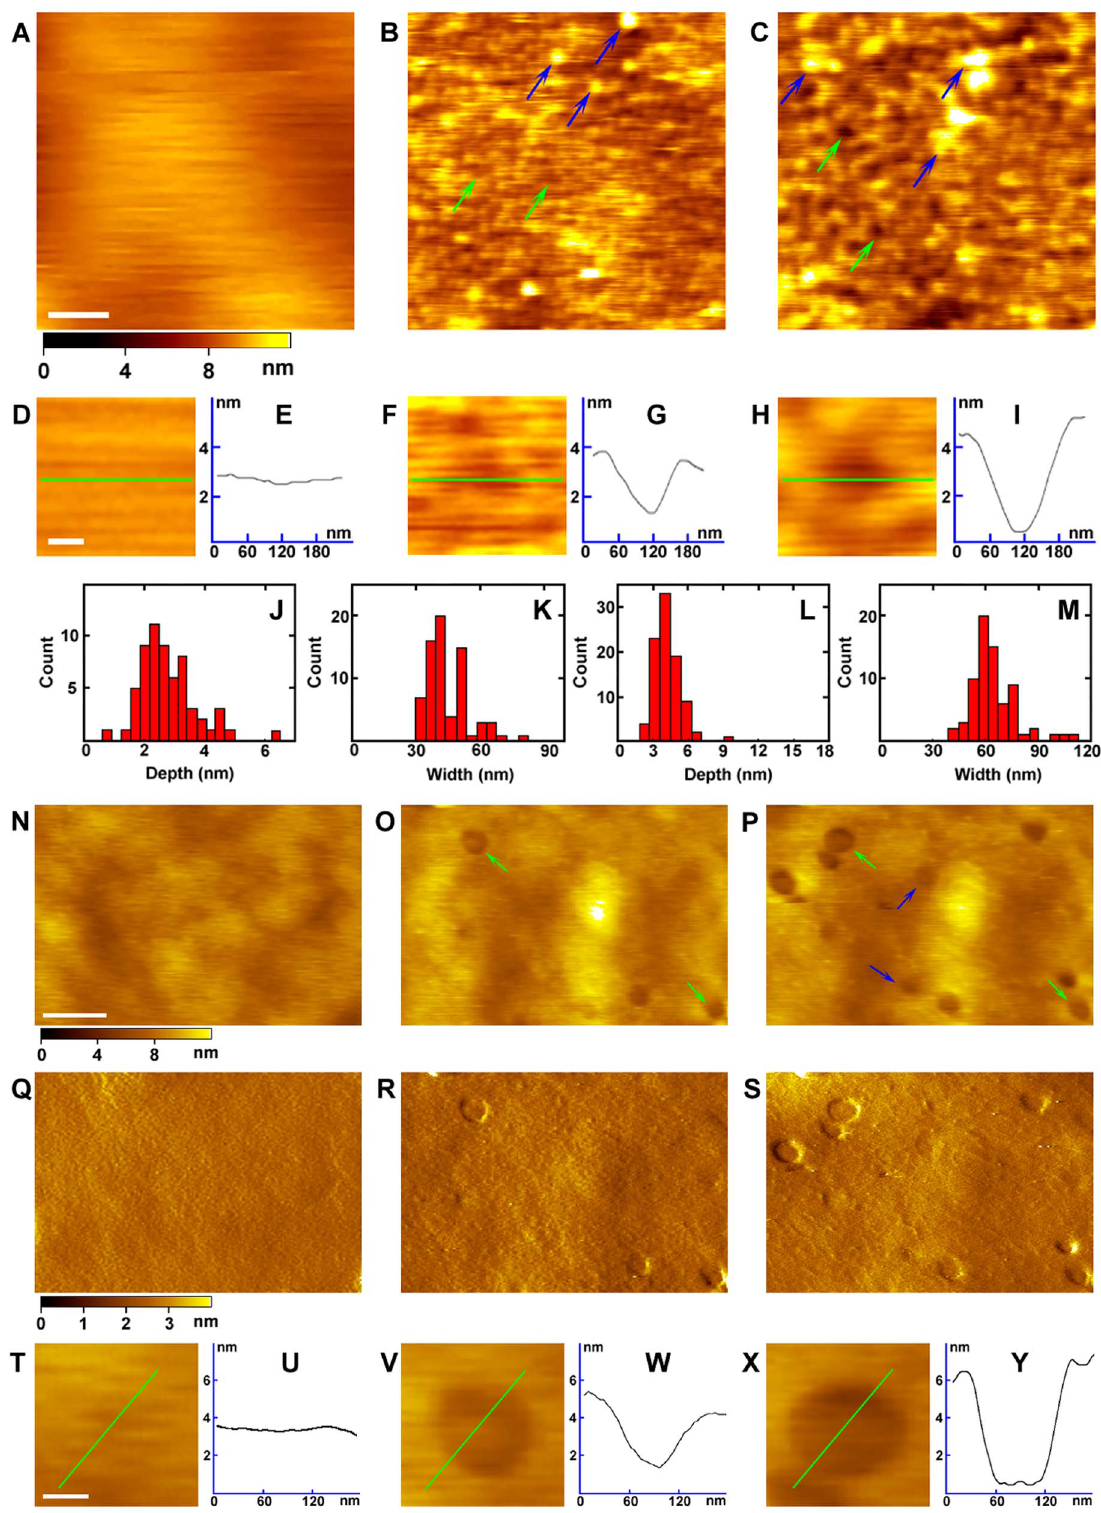
Figure 2. Digestion of the ectoplasmic side of the cell membrane with proteinase K or collagenase 3. (A) The AFM topographic image of the ectoplasmic side of the cell membrane. (B and C) The AFM topographic image of the ectoplasmic side of cell membranes treated with proteinase K (B) and M b CD (C) in sequence. (D, F and H) The magnified images from (A, B and C), respectively, showing the gradual deepening of the pits. (E, G and I) The cross section analysis along the green lines in (D, F and H), respectively. (J and K) The depth and width distributions of the pits after proteinase K treatment, respectively. (L and M) The depth and width distributions of the pits after M b CD treatment, respectively. (N) The AFM topographic image of the ectoplasmic side of the cell membrane without treatment. (O and P) The AFM topographic image of the ectoplasmic side of